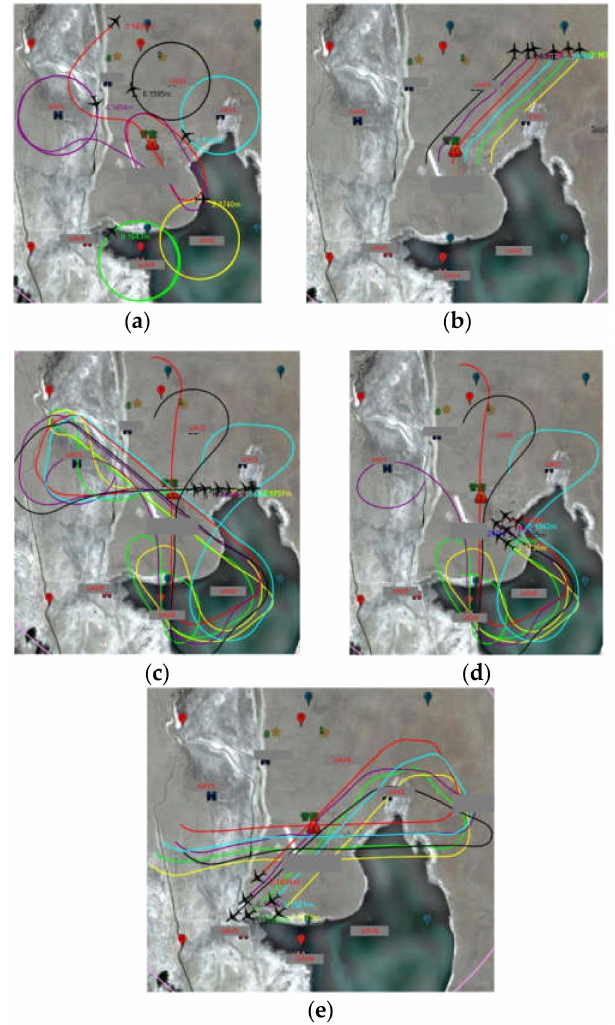
Figure 12. Four formations in the flight verification: ( a ) preparedness of UAVs after take-off; ( b ) formation of minimum formation vertical distance; ( c ) formation of minimum formation horizontal distance; ( d ) formation of minimum average distance; ( e ) formation of minimum